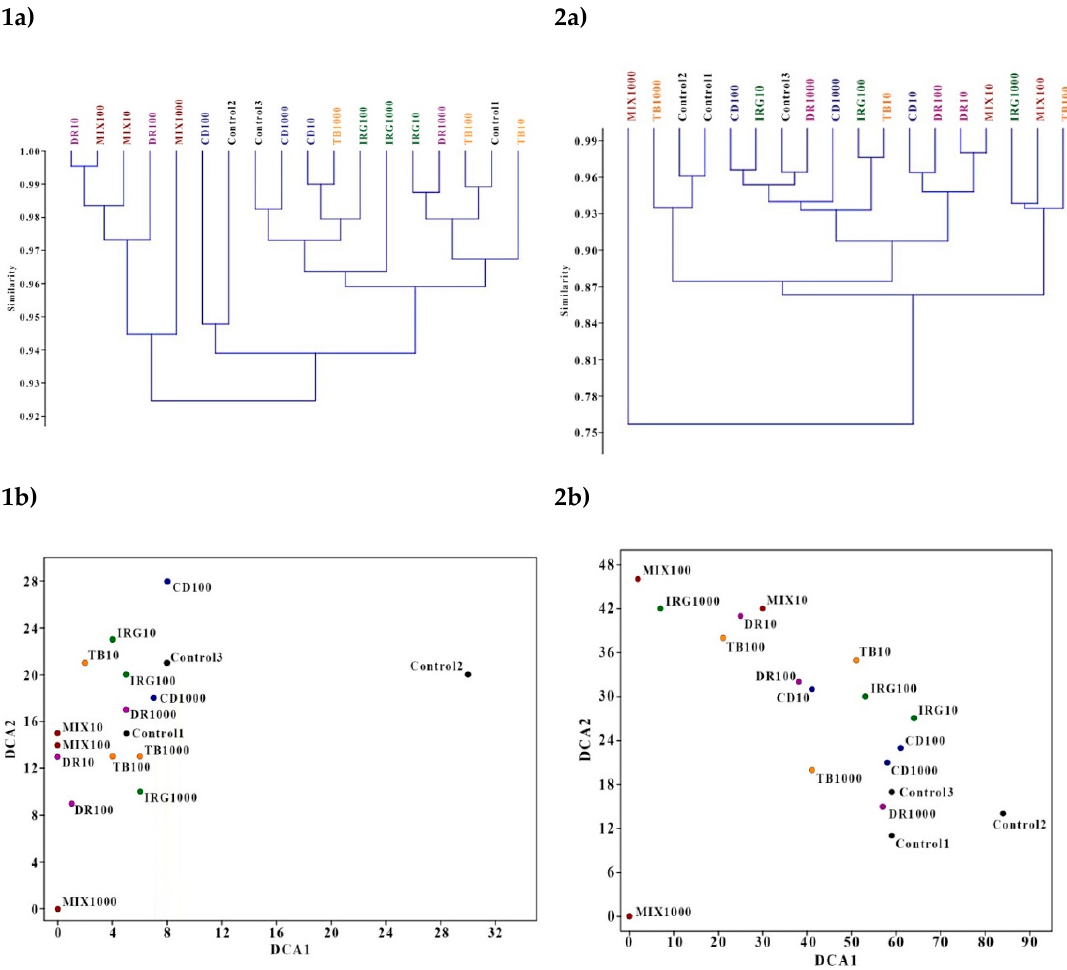
Figure 2. Phytoplankton cluster ( a ) and DCA ( b ) tests for water phase microcosm study: ( 1 ) with respect to the counted numbers of organisms mL − 1 , and ( 2 ) with respect to the estimated biovolumes.